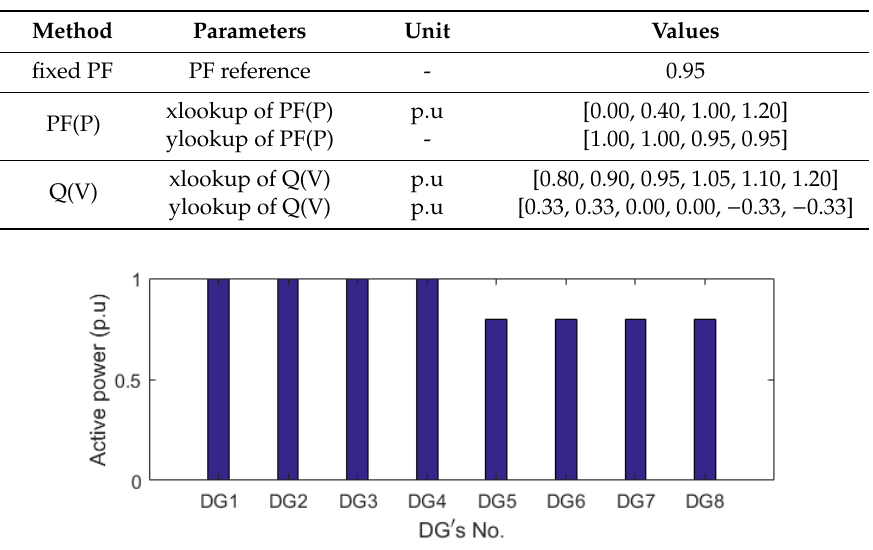
Figure 4. Active power output of DGs. Figure 5. Active power output of